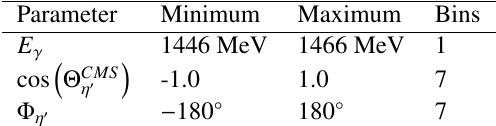
Table 1. Binning for the beam asymmetry determination Parameter Minimum Maximum Bins E γ 1446 MeV 1466 MeV -1.0 1.0 180 ◦ 7 4 η (cid:2) number